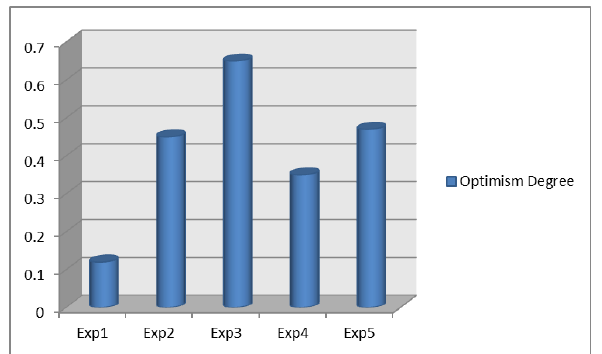
Figure 6. Vulnerability map for